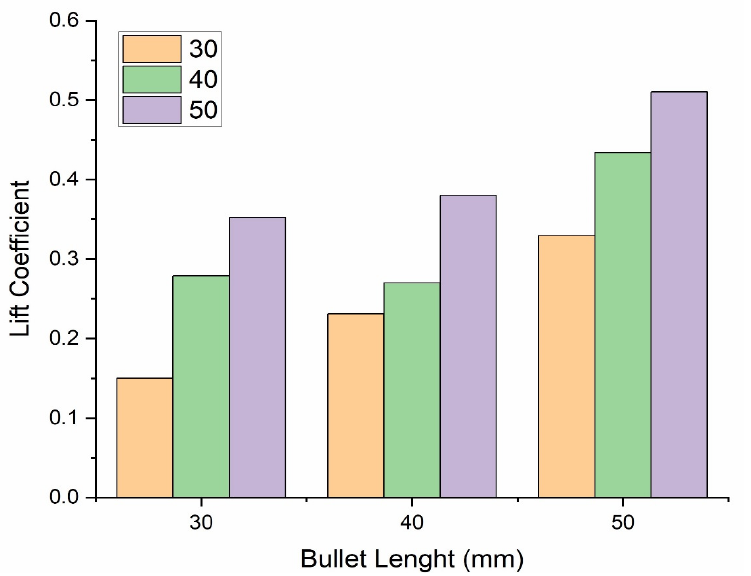
Figure 17. Simulated value of lift coefficient of bullet head (design II) at supersonic speed at 30°,40°,and 50° angle of attack.